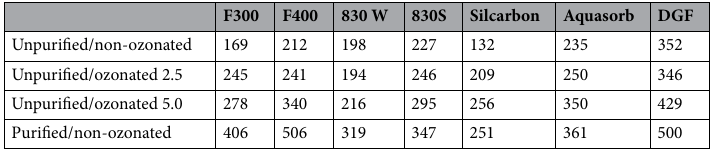
Table 2. Acidity (in µeq/g) of activated carbons: unpurified, non‑ozonated, unpurified ozonated (at pH 2.5 and 5.0) and purified non‑ozonated.